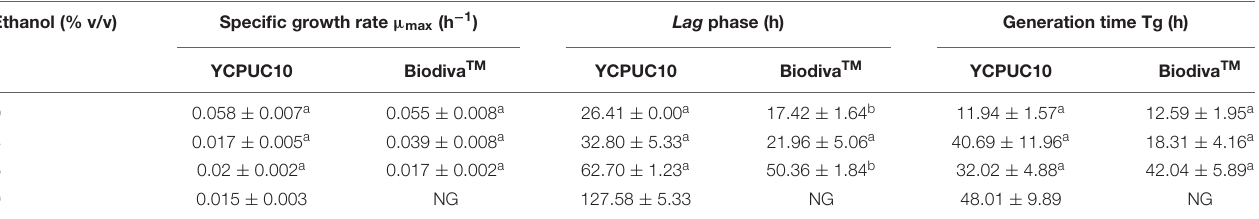
TABLE 1 | Kinetic parameters of the growth of strains of T. delbrueckii YCPUC10 (parental) and Biodiva TM (commercial), exposed to different concentrations of ethanol. Ethanol (% v/v) Specific growth rate µ max (h − 1 ) Lag phase (h) Generation time Tg (h) YCPUC10 Biodiva TM YCPUC10 Biodiva TM YCPUC10 Biodiva